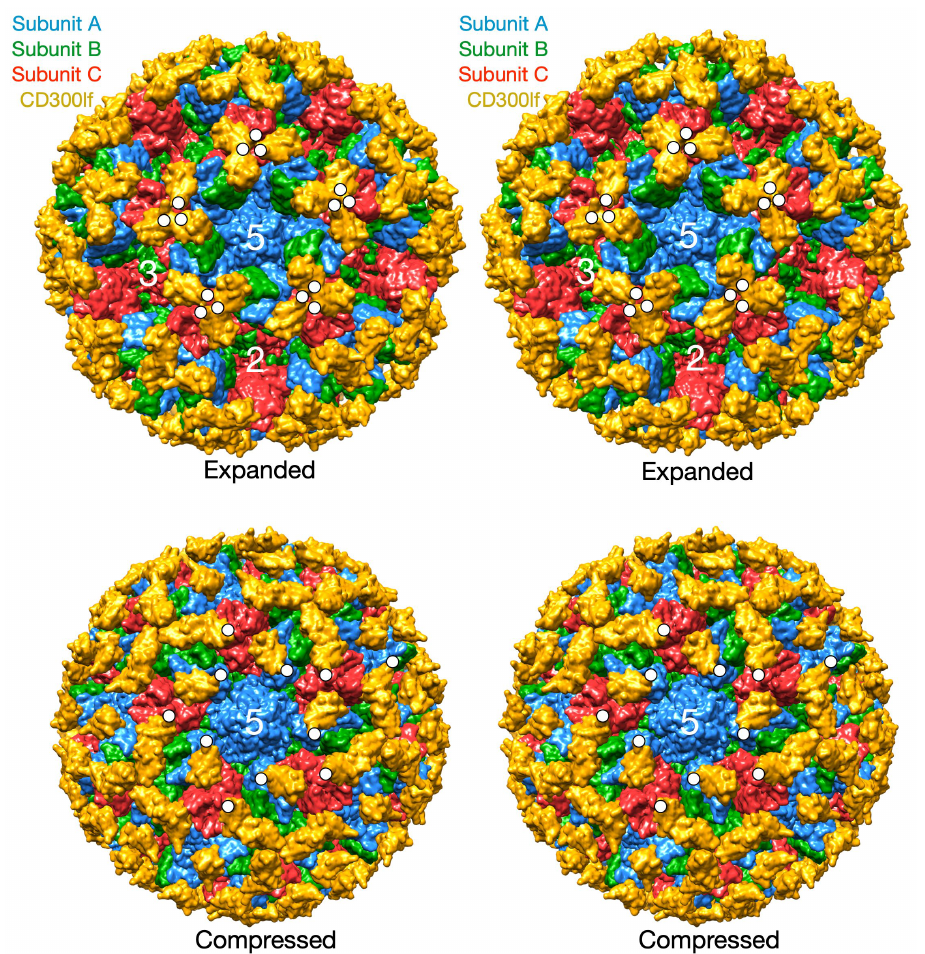
Figure 4. Models of the bound receptor in the compressed and expanded virions. The structures of the MNV/receptor complex in the expanded state using the cryo-EM structure and the compressed state using the relative P domain orientation observed in NV. The A, B, and C subunits are blue, green, and red respectively and the receptor is shown in yellow. The C-termini of several copies of CD300lf are highlighted by white